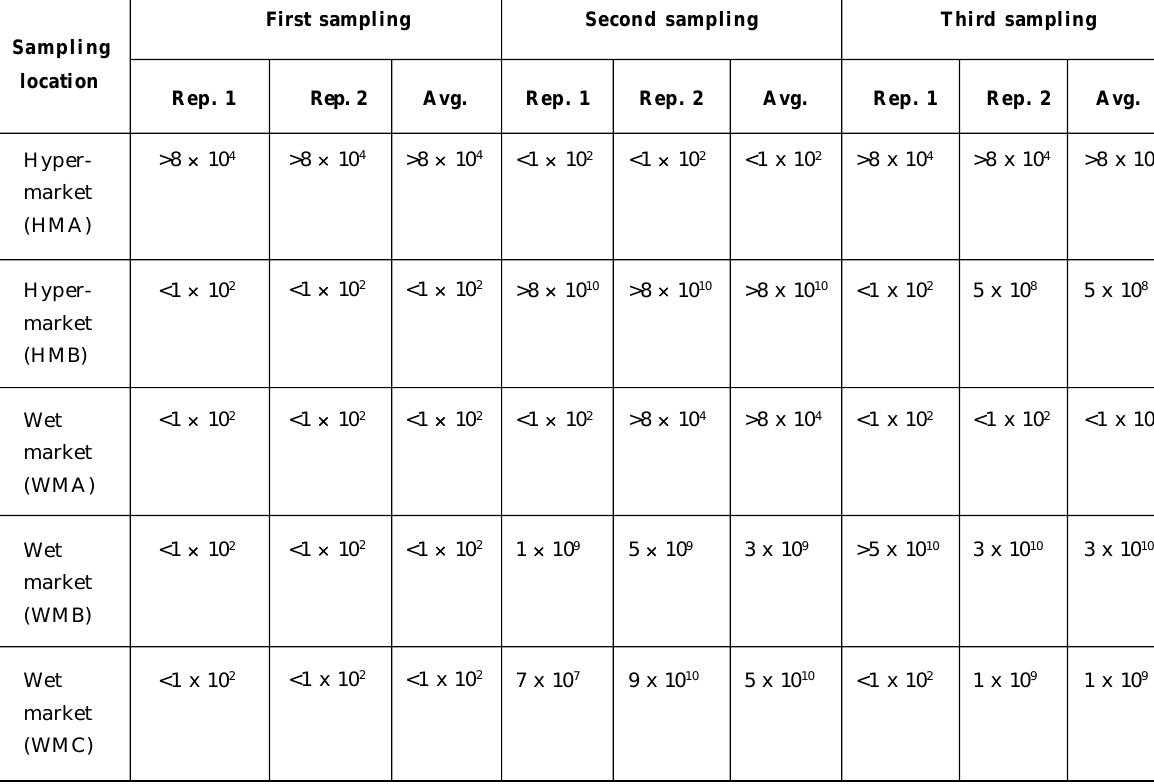
Table 1: Microbial loads of Salmonella spp. in farmed shrimps at selected retails in Kuala Lumpur